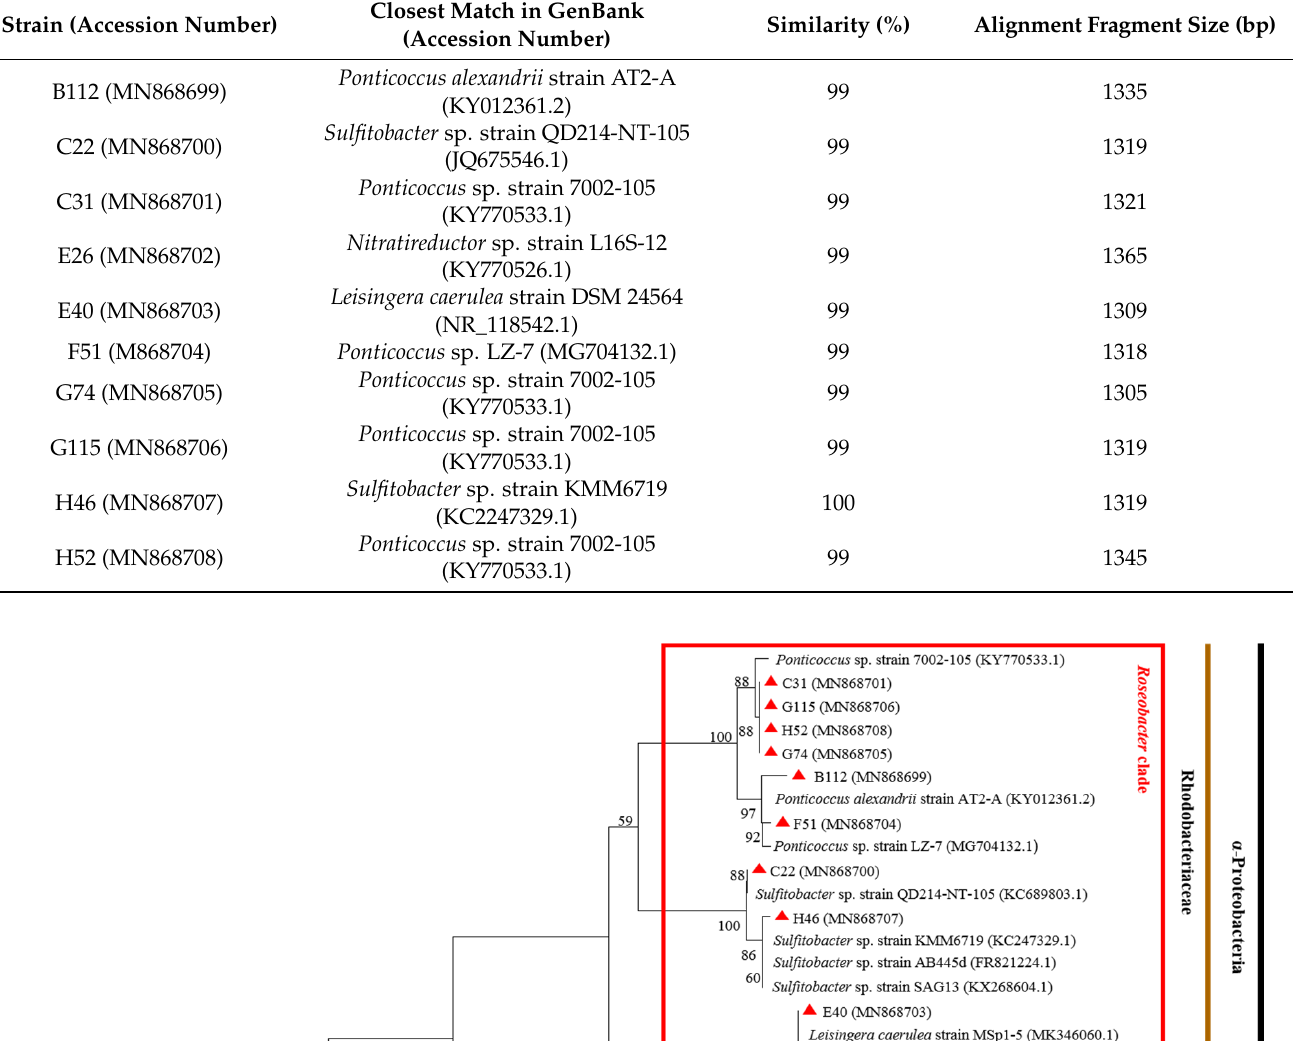
Table 1. Identification of 16S rRNA sequences of 10 QS bacteria isolated from typical marine red tide algae. Strain (Accession Number) Closest Match in GenBank (Accession Number) Similarity (%) Alignment Fragment Size (bp)